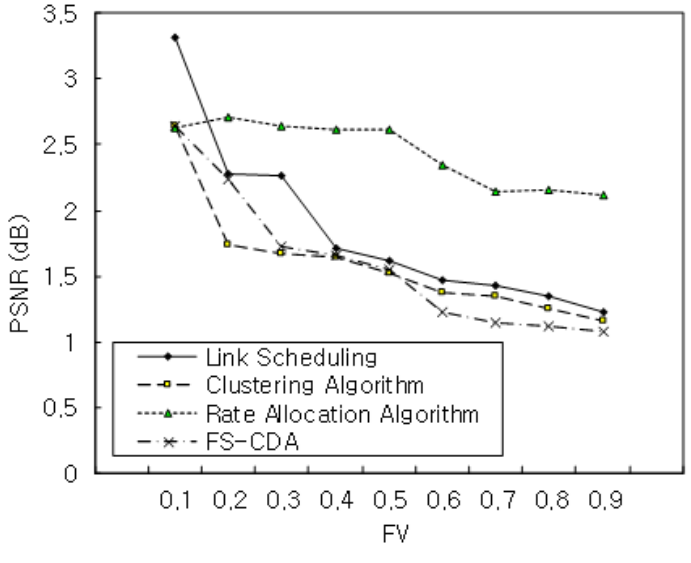
Figure 11. PSNR with FV.